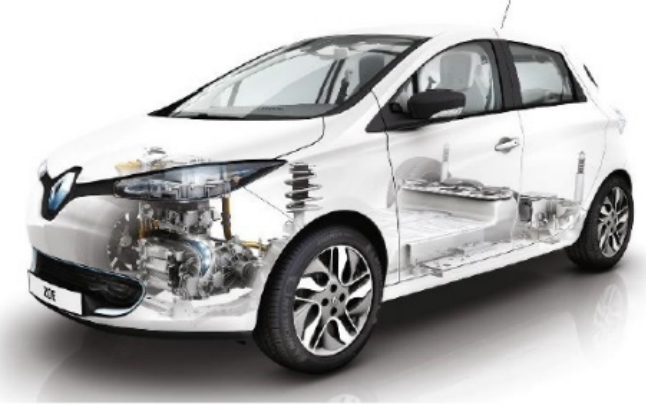
Figure 1. Electric vehicle Renault ZOE.